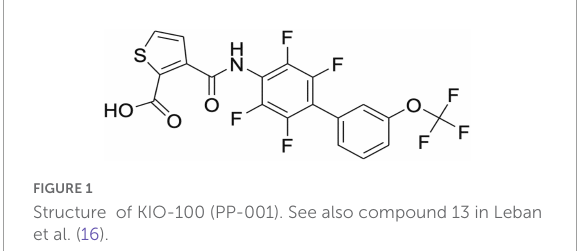
FIGURE1 Structure of KIO-100 (PP-001). See also compound 13 in Leban et al. (16).